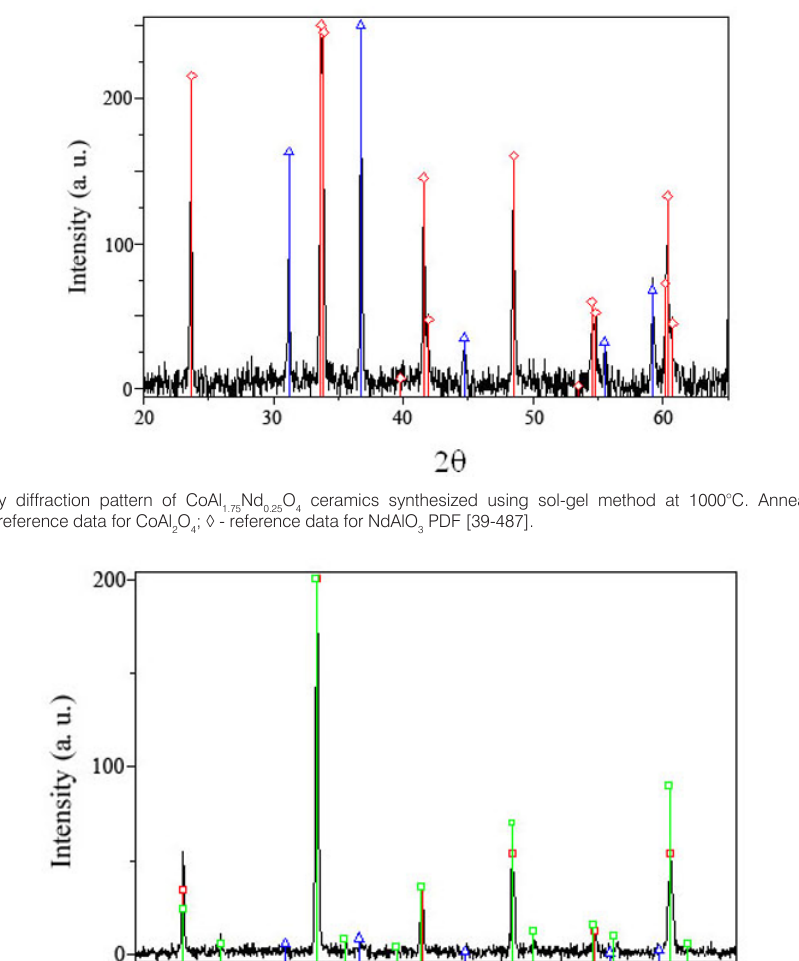
Nd O ceramics synthesized using sol-gel method at 1000°C. Annealing time was 10 h. 1.5 0.5 4 O ; - reference data for NdAlO and NdCoO PDF 2 4 3 3